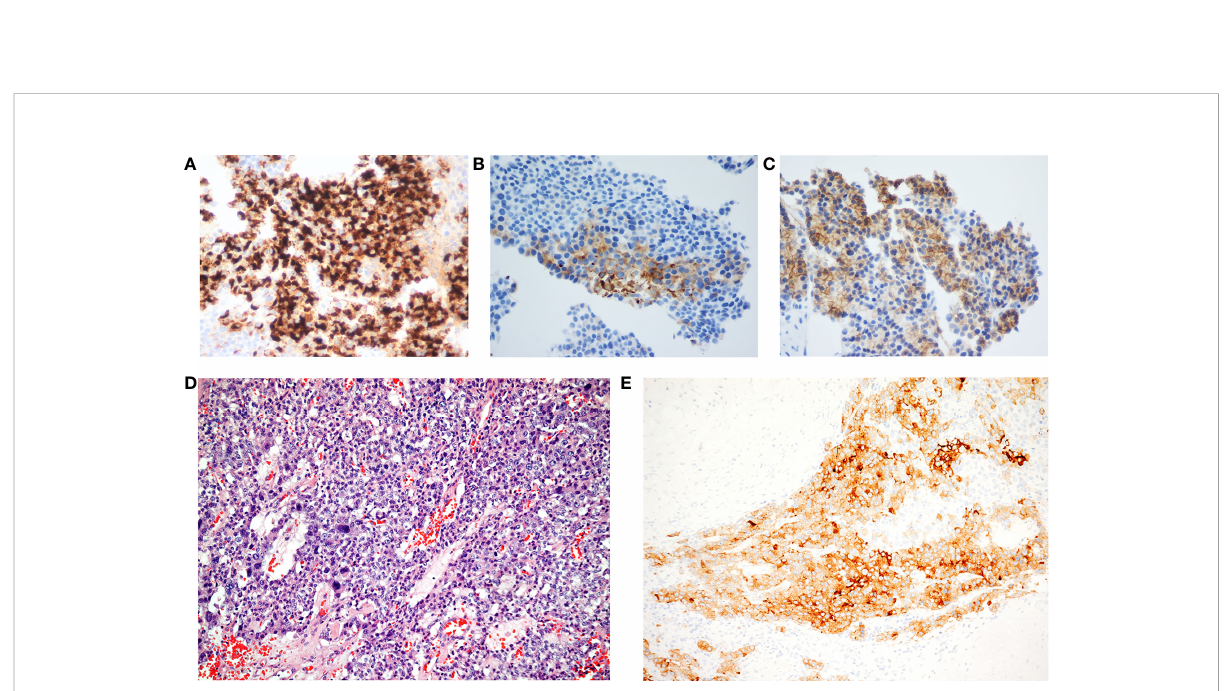
FIGURE 2 (A) Chromogranin, (B) synaptophysin, (C) somatostatin receptor 2A, and (D) monomorphous round to cuboidal cells arranging in solid and trabecular patterns. These cells have rich cytoplasm, and salt and pepper nuclei (hematoxylin – eosin stain; original magni fi cation, 100×). (E) The immunohistochemical study reveals immunoreactivity of synaptophysin (original magni fi cation, 100×).